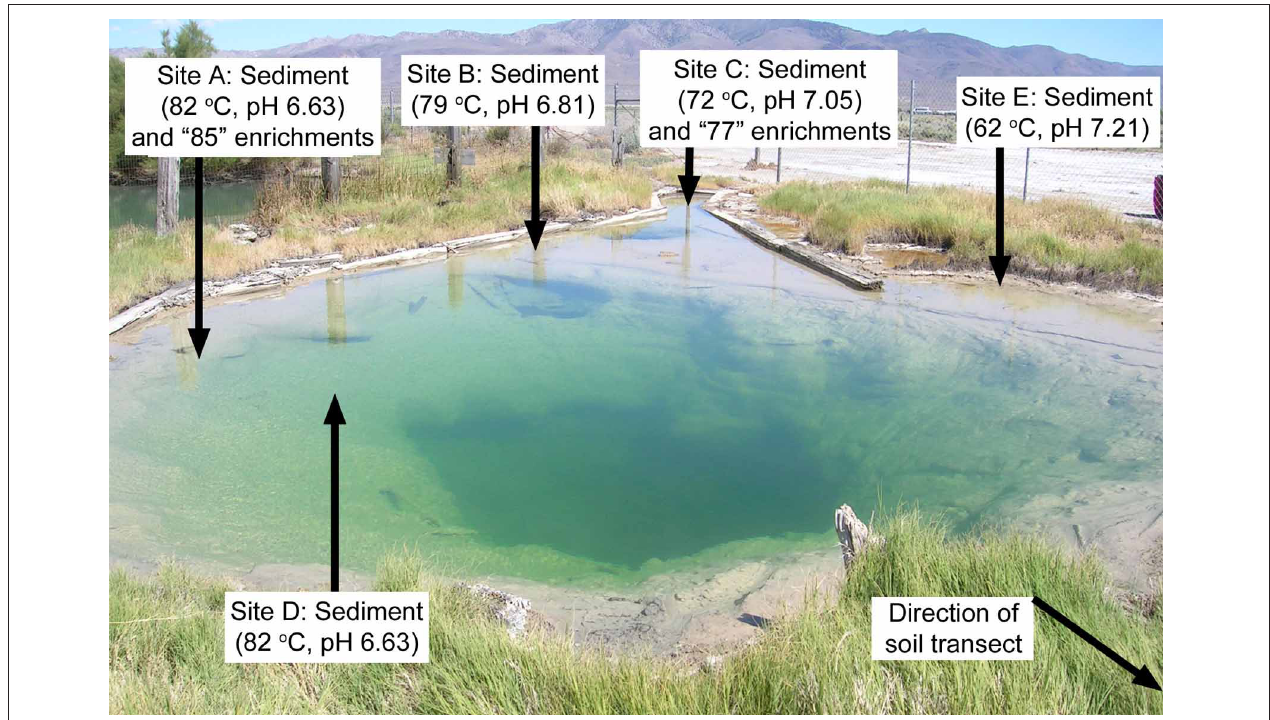
FIGURE 1 | Sites in GBS where sediments were collected and in situ cellulolytic enrichments were incubated. The soil transect started at the edge of the hot spring at the lower right corner of the